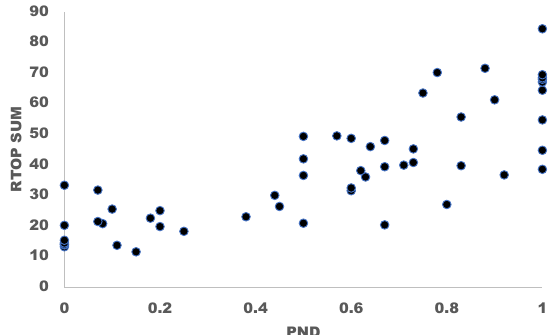
Fig. 3 Scatter of PND and RTOP-Sum. Correlation of r n 54 instructors =